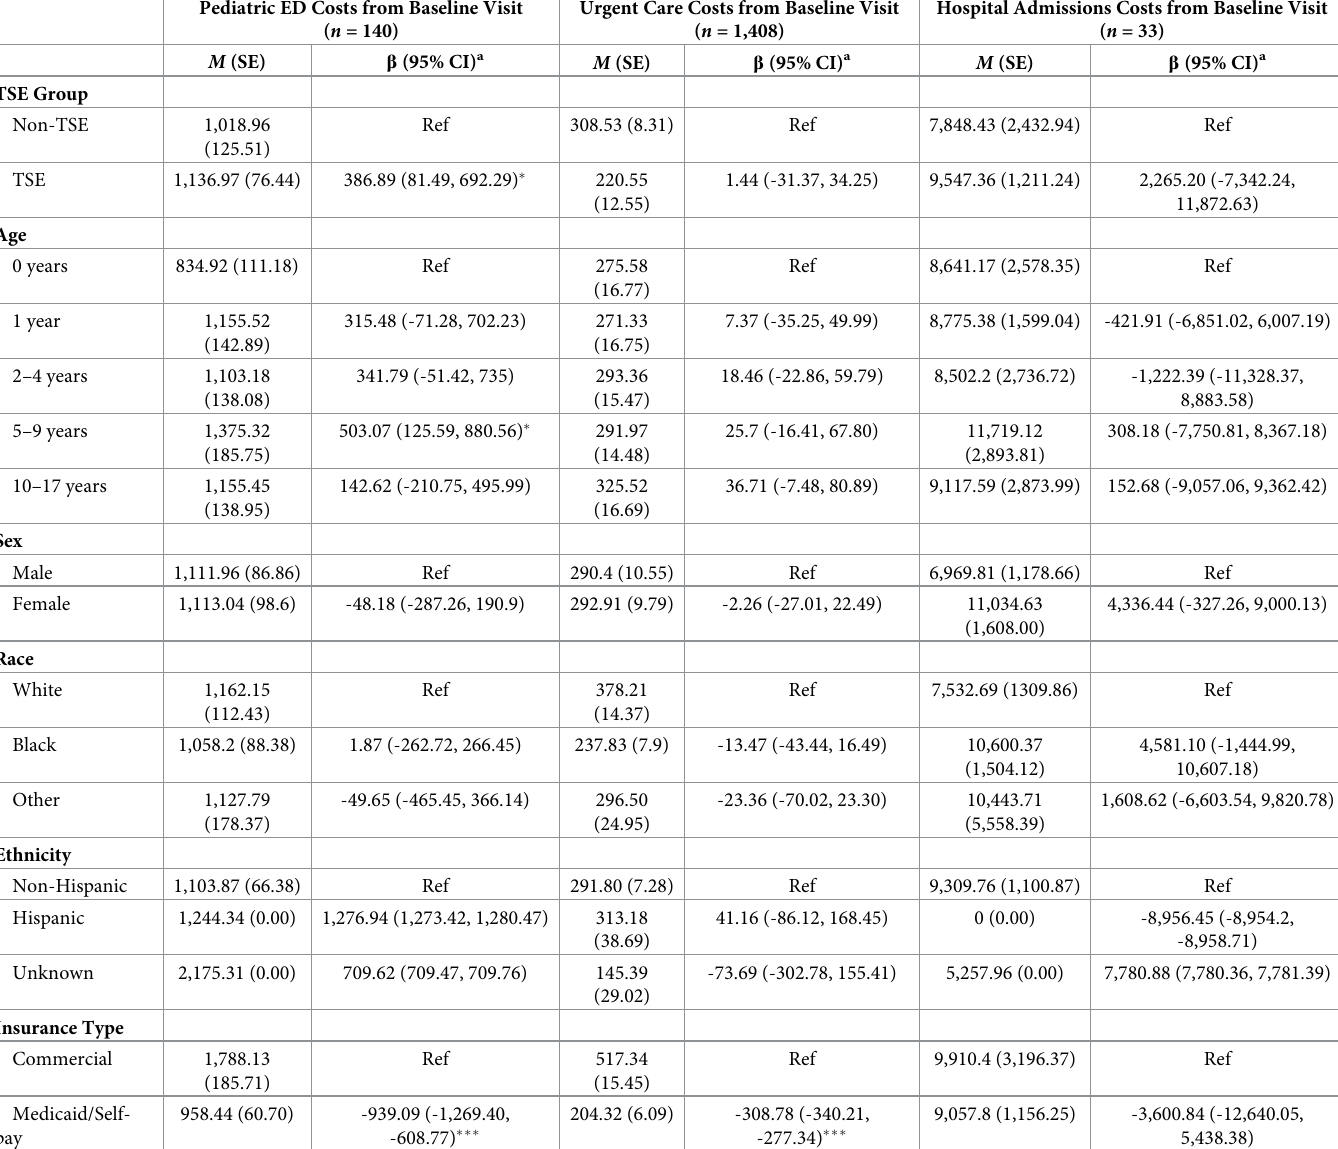
Table 4. Tobacco smoke exposure group status and pediatric ED visit, urgent care visit, and hospitalization costs from baseline among nonsmoking children ages 0–17 years. Pediatric ED Costs from Baseline Visit Urgent Care Costs from Baseline Visit Hospital Admissions Costs from Baseline Visit ( n = 140) ( n = 1,408) ( n =